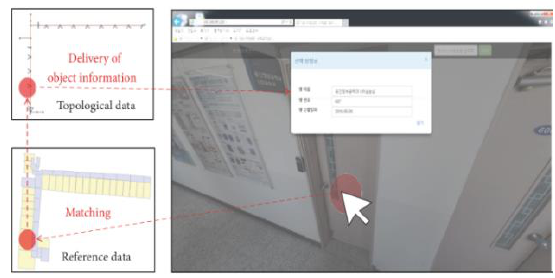
Figure 2. Image and Topological Data Fusion Figure 1. Delivery of object information in Omnidirectional image from Topological data through a Reference data (Jung and Lee, 2015)